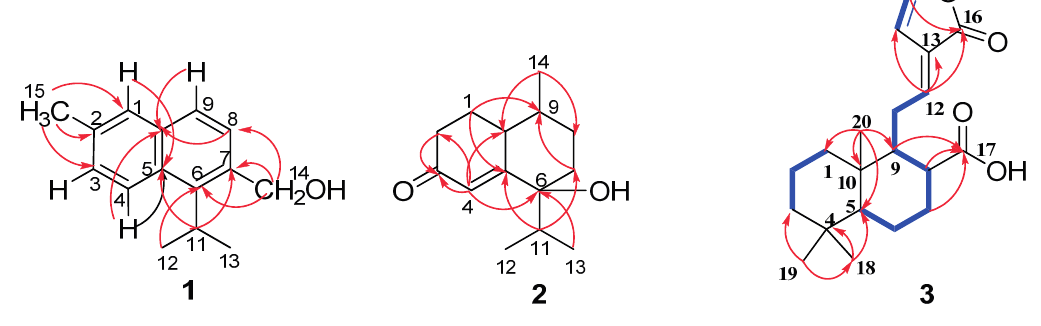
Figure 2. Key COSY and HMBC correlations of compounds 1 – 3